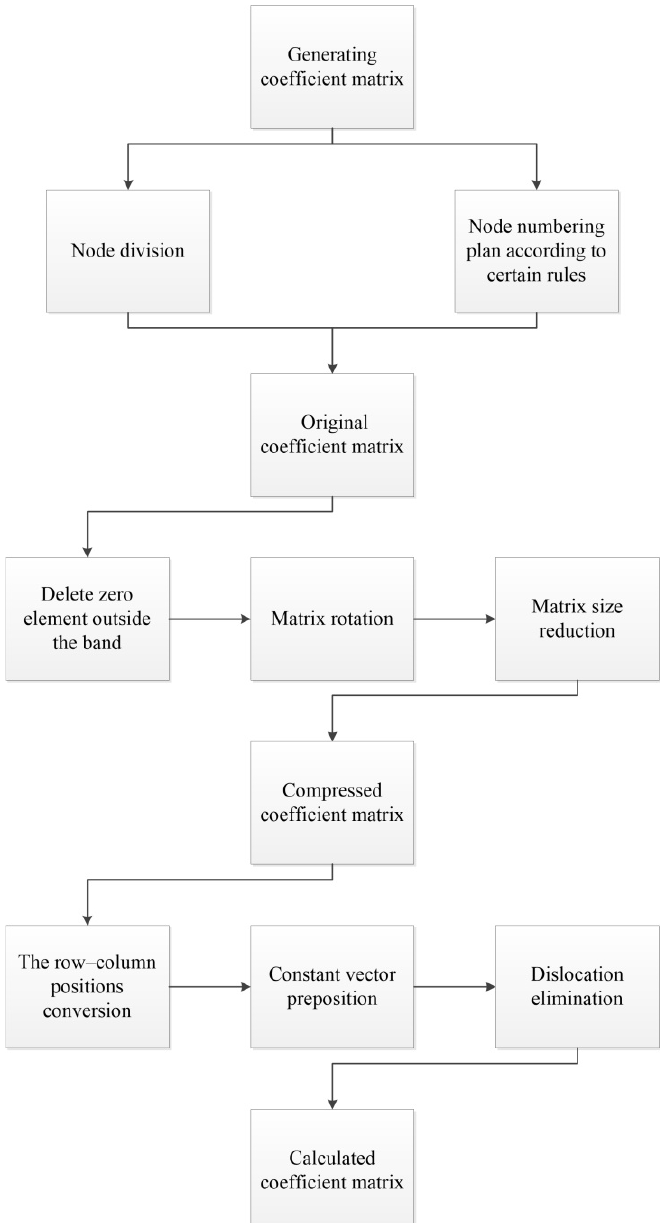
Figure 5. Flowchart of the compressed storage and solution method.